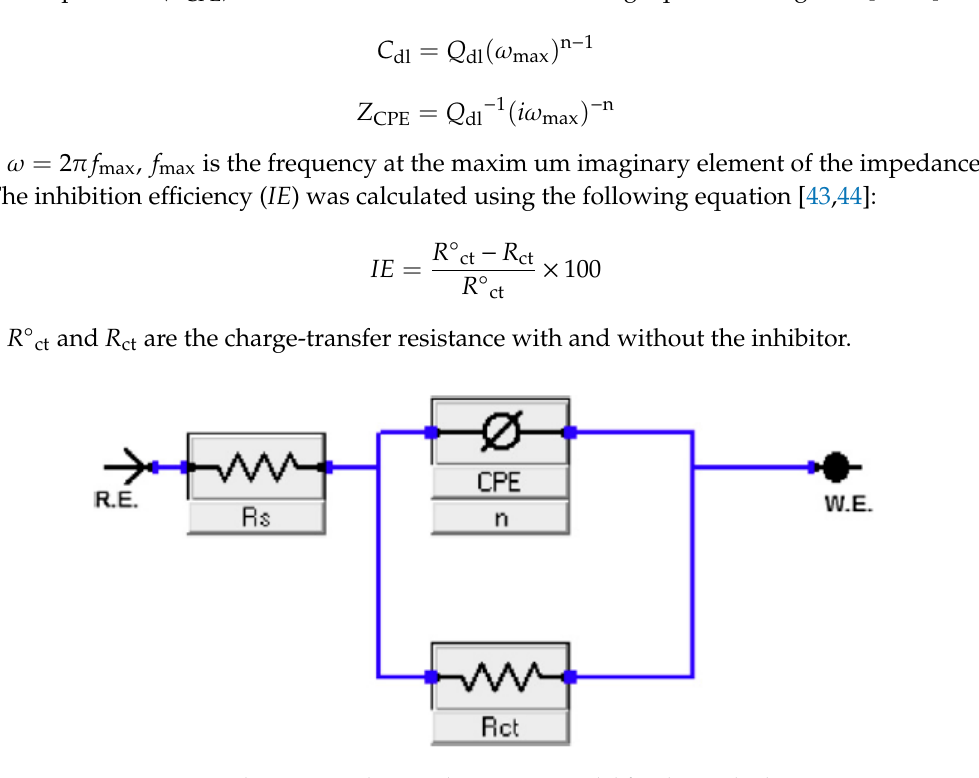
Figure 14. Simulation of EIS (a) and Bode (b) plots for MS in 1 M HCl at 20 °C. top: bottom: